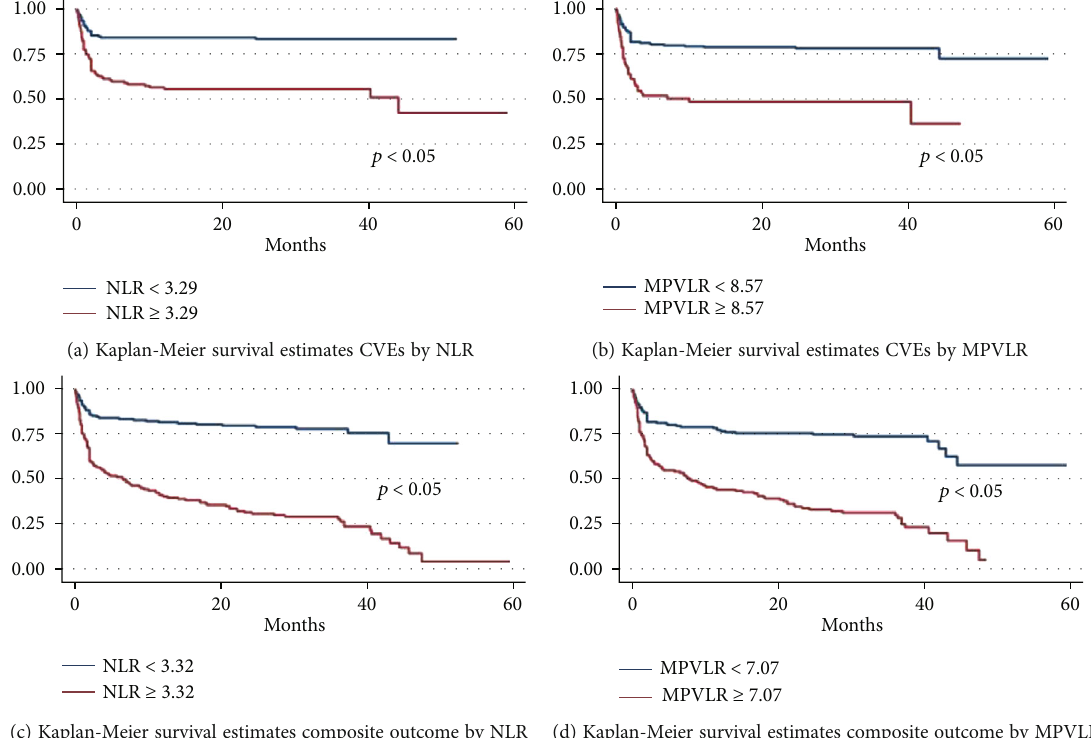
Figure 1: Kaplan-Meier survival estimation of NLR and MPVLR for cardiovascular events and a composite